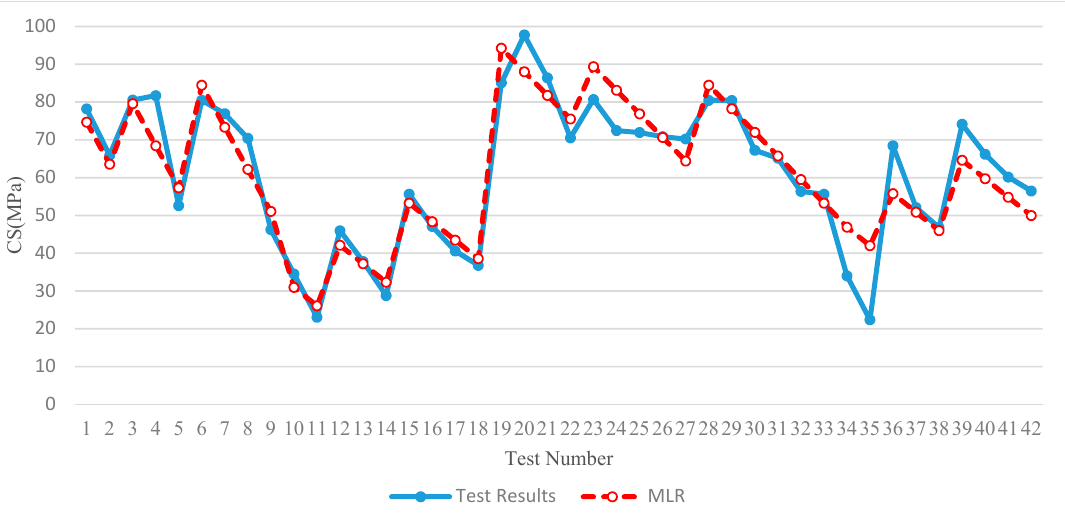
Figure 13. Comparison between observational and computational methods.